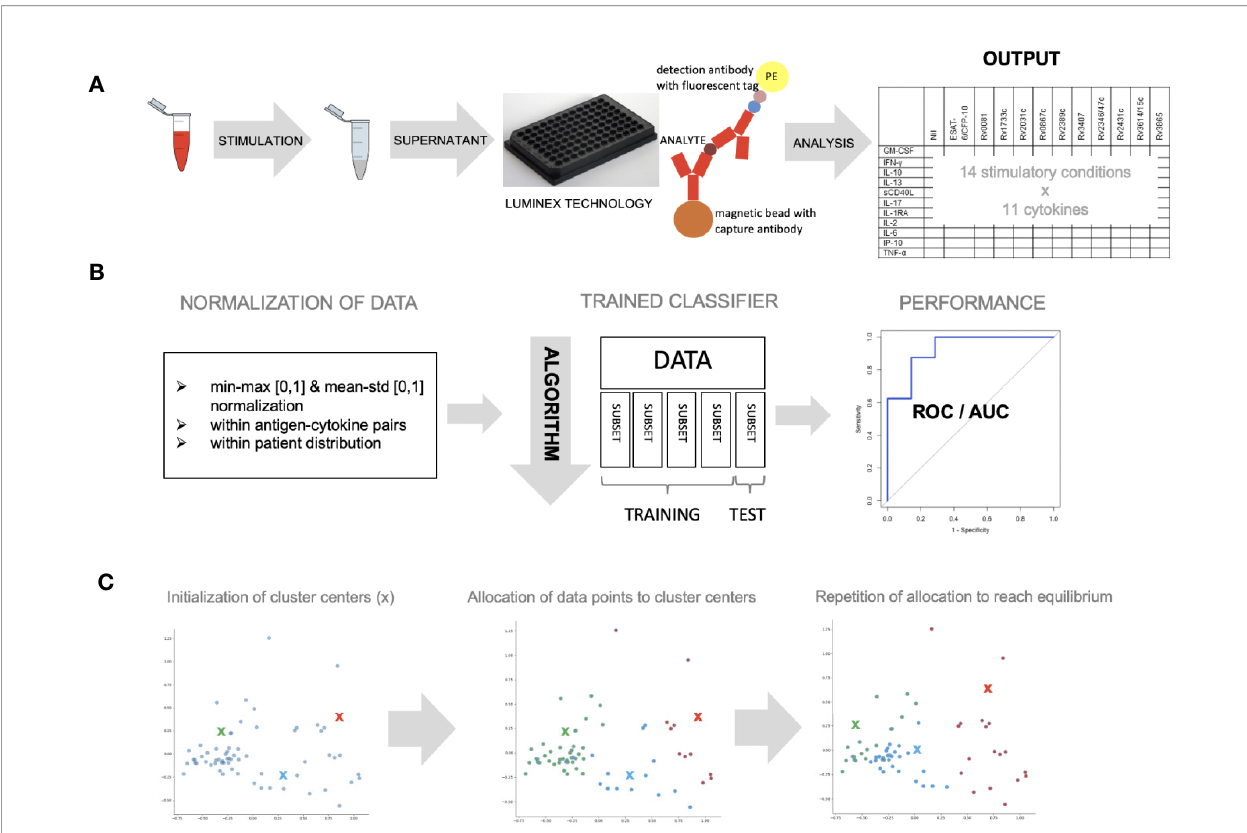
FIGURE 1 | Whole blood was stimulated with novel antigens and data was analyzed with different machine learning algorithms. (A) Whole blood was stimulated with 11 mycobacterial antigens, left unstimulated and with a positive control, overnight and supernatant was analyzed using Luminex technology to measure 11 different cytokines (B) data was normalized within antigen – cytokine pairs using min-max or mean – std normalization or within patient distribution using the latter only. Data (n = 59) was divided into fi ve equal parts and a classi fi er discriminating healthy vs. sick children was trained using four subsets and tested on one subset (cross- validation). The algorithm ’ s parameters were adjusted until performance was optimal. ROC curves were used to measure performance. (C) K-means clustering approach was used to allocate individual data points to three cluster centers randomly. This approach was repeated until optimal data point allocation was reached meaning the sum of the distances from data point to cluster centers is